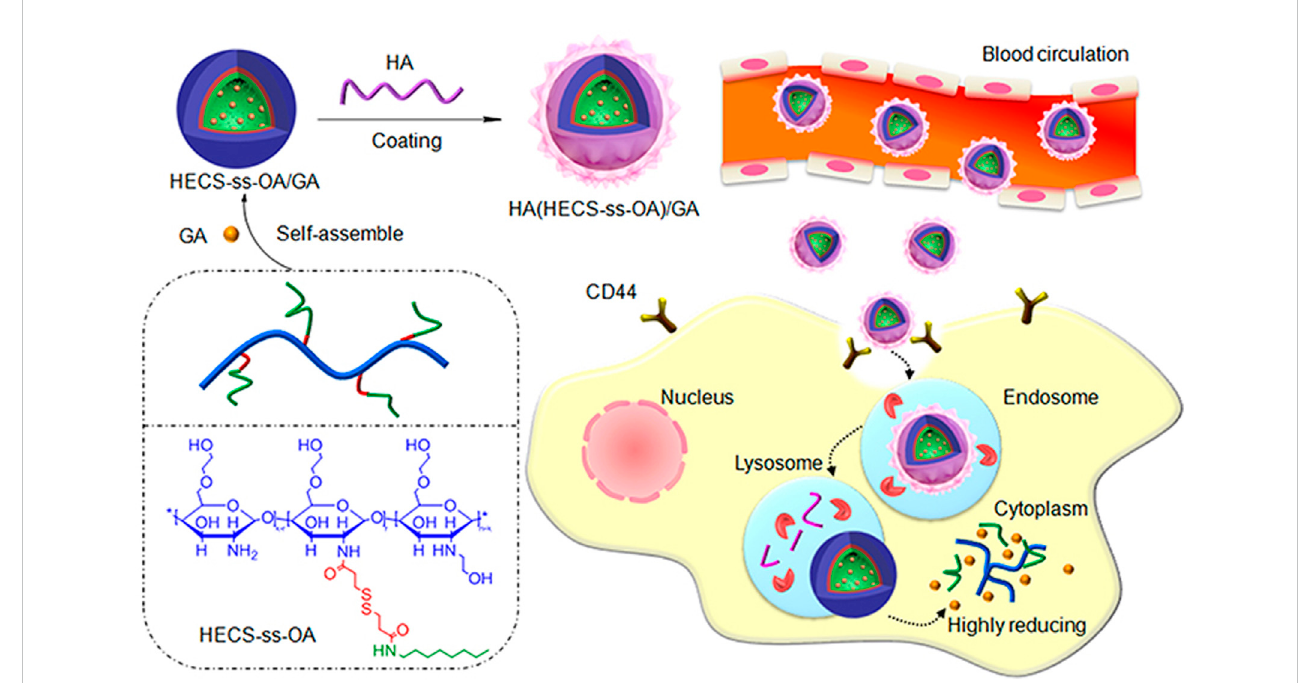
FIGURE 3 The structure of HA (HECS-ss-OA)/GA and the illustration of tumor cytoplasm-selective rapid GA delivery by the HA-coated redox-sensitive HA (HECS- ss-OA)/GAnanoparticles.GAwassolubilizedintotheinnercoreofHECS-ss-OAmicelles,whileHAwasemployedtocoatoutsideHECS-ss-OA/GA.HECS-ss- OA,redox-sensitiveO,N-hydroxyethylchitosan − octylamineconjugates;GA,gambogicacid;HA,hyaluronicacid.Reproducedwithpermissionfrom(Xuetal., 2019) Copyright (2019) Dove Medical Press